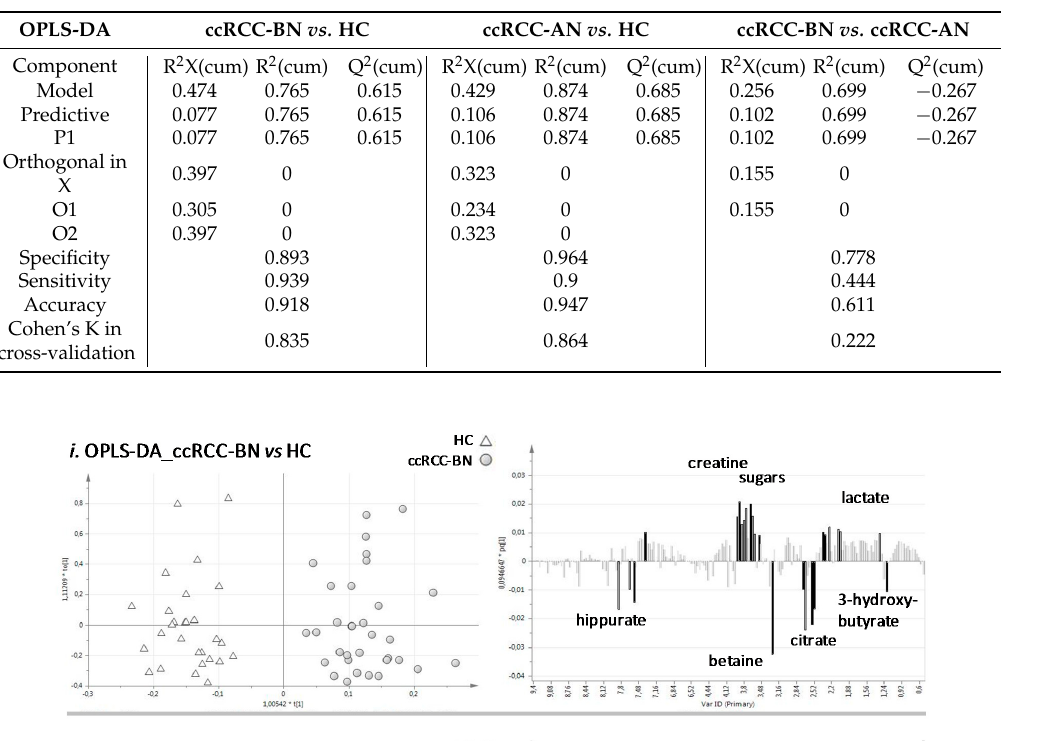
Table 2. Parameters describing the three Orthogonal Partial Least Squares-Discriminant Analysis (OPLS-DA) models obtained using SIMCA software: R 2 X(cum) (cumulative R 2 X, X variance explained by the current components), R 2 (cum) (cumulative R 2 , goodness of fit), and Q 2 (cum) (cumulative Q 2 , Q 2 up to the specified component, where Q 2 is the fraction of Y variation predicted by the X model in a component, according to cross-validation), specificity, sensitivity, accuracy, and Cohen’s K calculated in cross-validation.